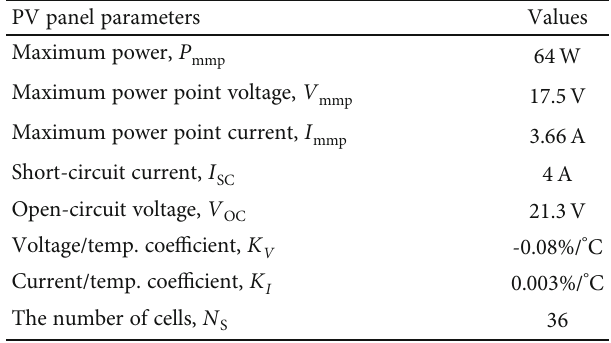
Table 1: Main product parameters of the PV module MSX-64. PV panel parameters